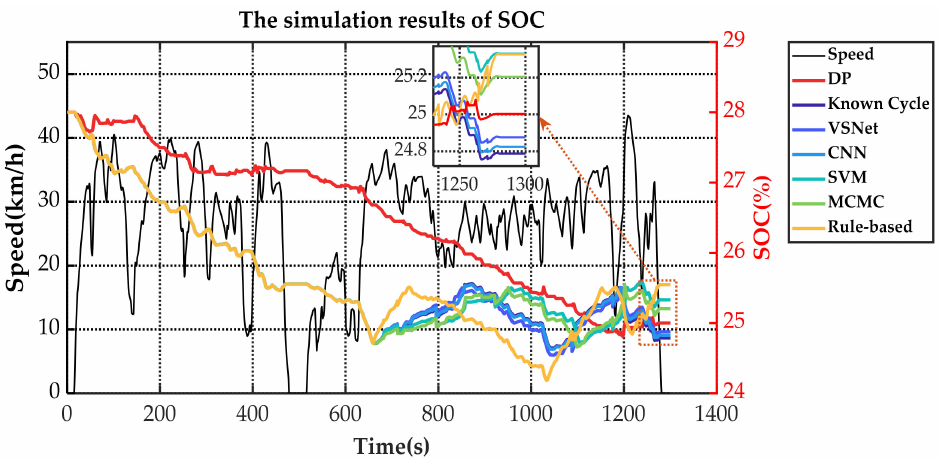
Figure 21. The SOC during the simulations with different energy management strategies.